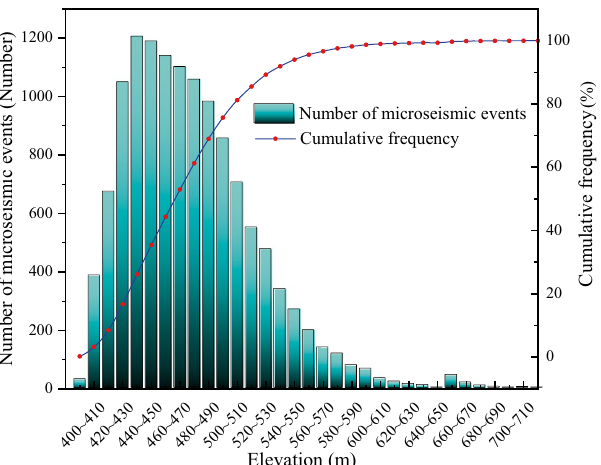
Figure 4. Histogram of quantitative distribution in elevation interval of microseismic